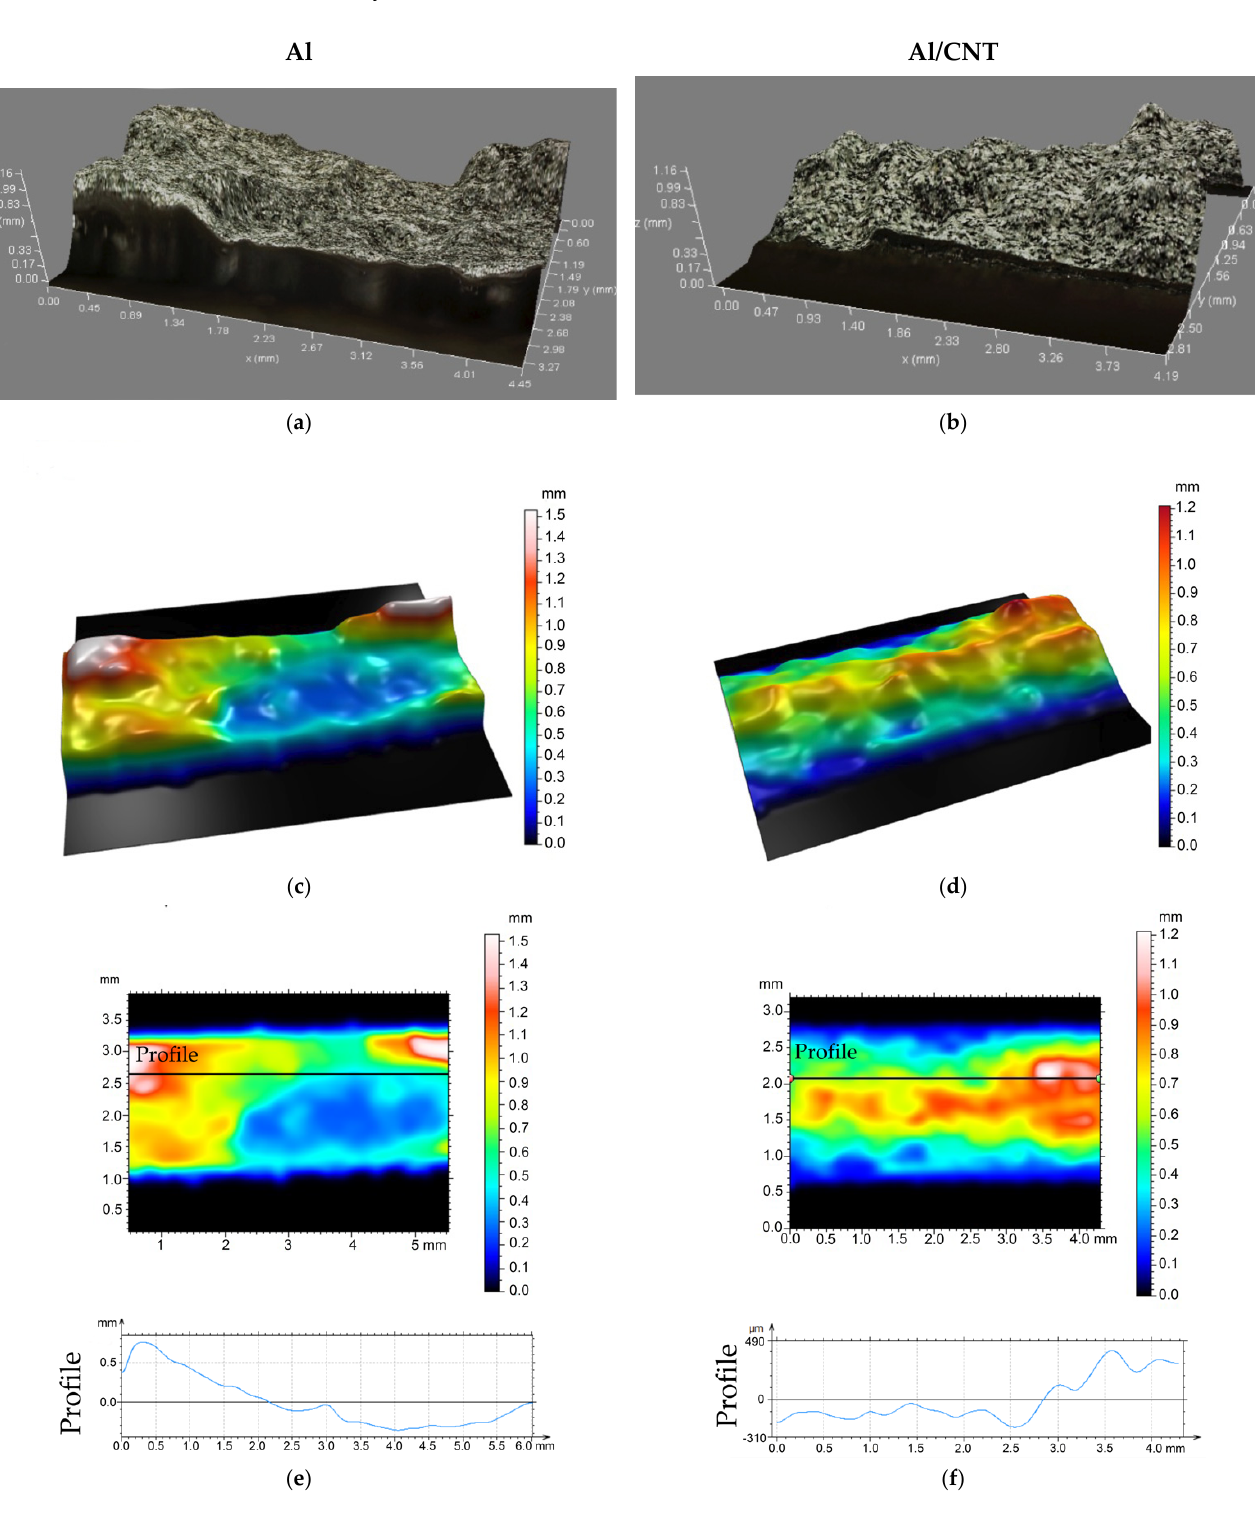
Figure 8. Surface analysis of the fracture surface of the samples after the tensile test: ( a , b ) digital optical microscope image of the area selected of Al and Al/CNT samples; ( c , d ) 3D image of the area of the ( a , b ); ( e , f ) profile of the line selected in the surface image.